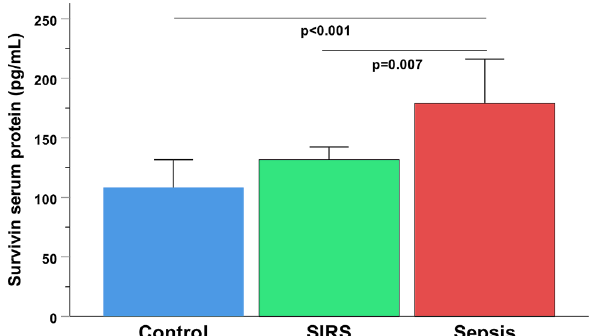
Figure 1. Serum levels of survivin-WT (isoform 1 or alpha) in septic patients in comparison to patients with non-infectious (trauma) systemic inflammatory response syndrome (SIRS) and healthy controls. Bars represent Medians, error bars 95% Confidence Intervals. Connectors indicate significantly higher levels in sepsis.